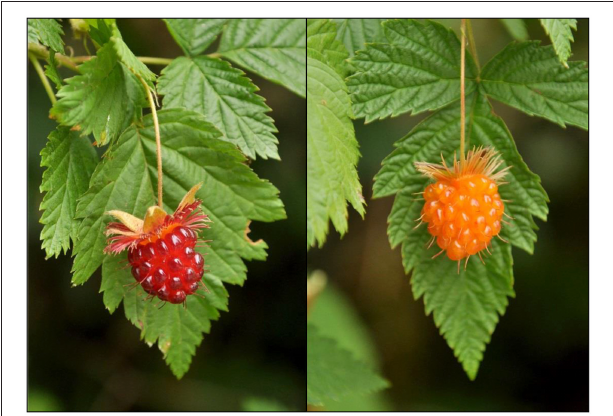
FIGURE 1 | Red (left) and orange (right) fruits of Rubus spectabilis .